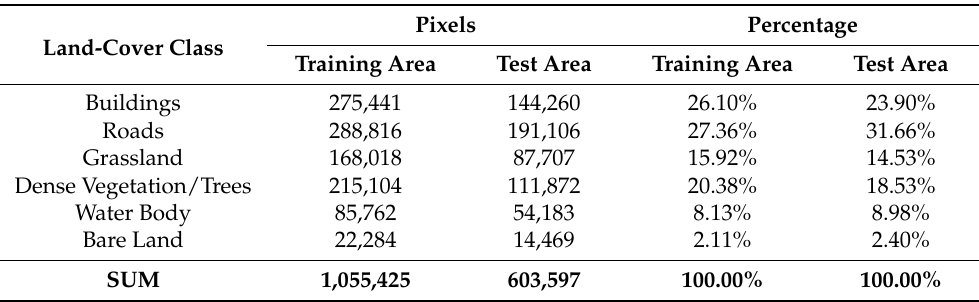
Figure 2. The ground-truth maps of the ( a ) training and ( b ) test areas. Table 1. Training and test data class distribution (i.e., number of pixels and area percentage) in the ground-truth dataset.